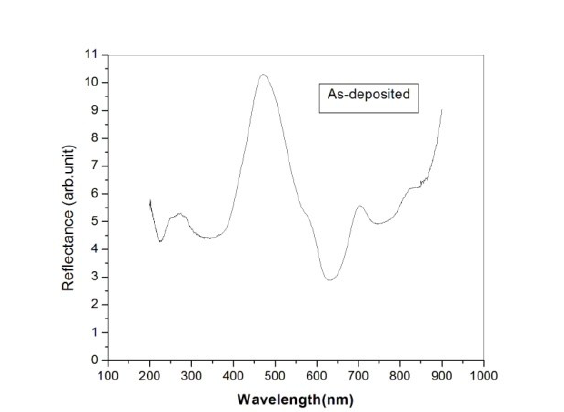
FePc thin film. 16